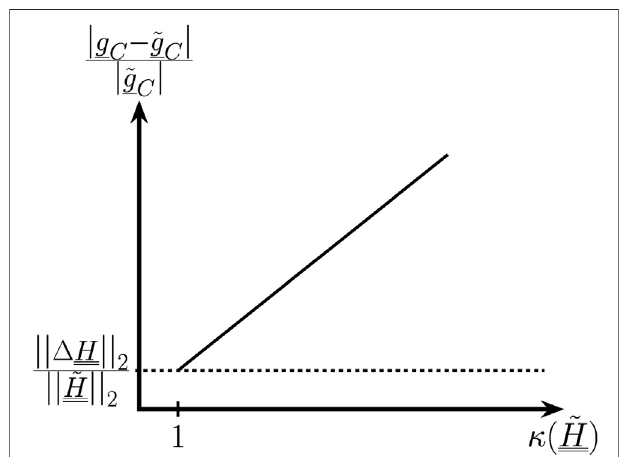
FIGURE 2 | Sketch of the upper bound for the relative estimation error resulting from measurement position errors with respect to the condition number κ (cid:1) ~ H (cid:3) of the shape